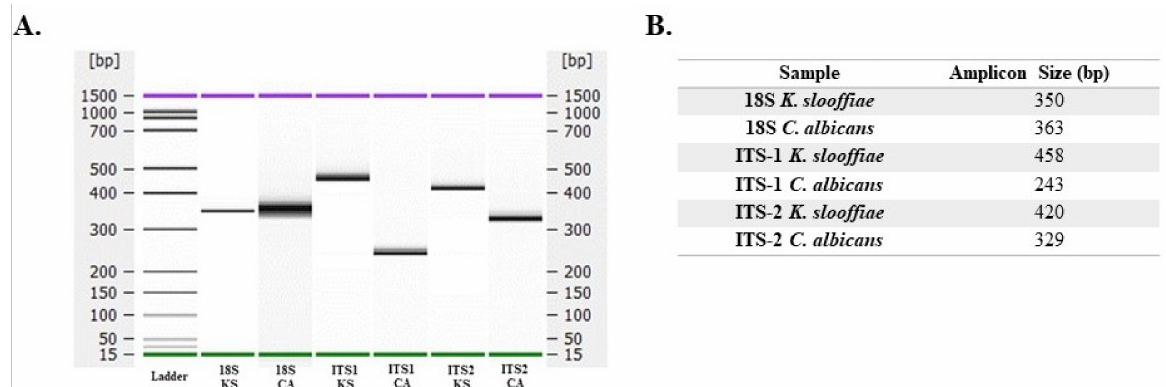
Figure 4. DNA amplicon size based on fungal-specific primer target. DNA isolated from K. slooffiae (KS) or C. albicans (CA) was amplified utilizing previously published primers (Table 1) for 18S, ITS-1, and ITS-2. Samples were run on an Agilent Bioanalyzer 2100; resulting amplicon sizes are shown by gel ( A ), and expected amplicon sizes are summarized ( B